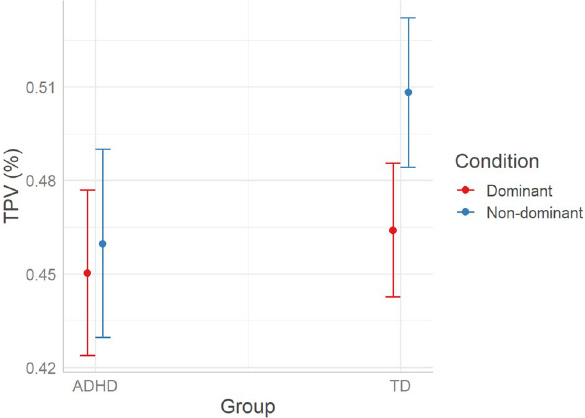
Figure 5. Predicted effects of Condition*Group and Age on TPV (n trials = 6011, n ADHD = 17, n TD = 26, TPV is expressed as a percentage within the 0:1 range, estimated marginal means with whiskers representing 95% confidence